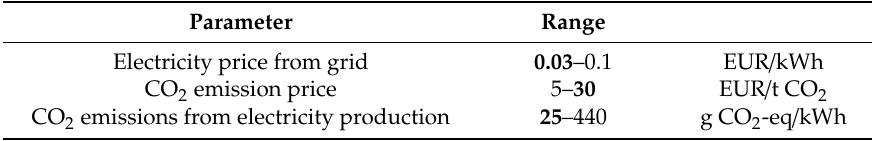
Table 4. Economic parameters related to key performance indicators. Base case figures are given in bold.